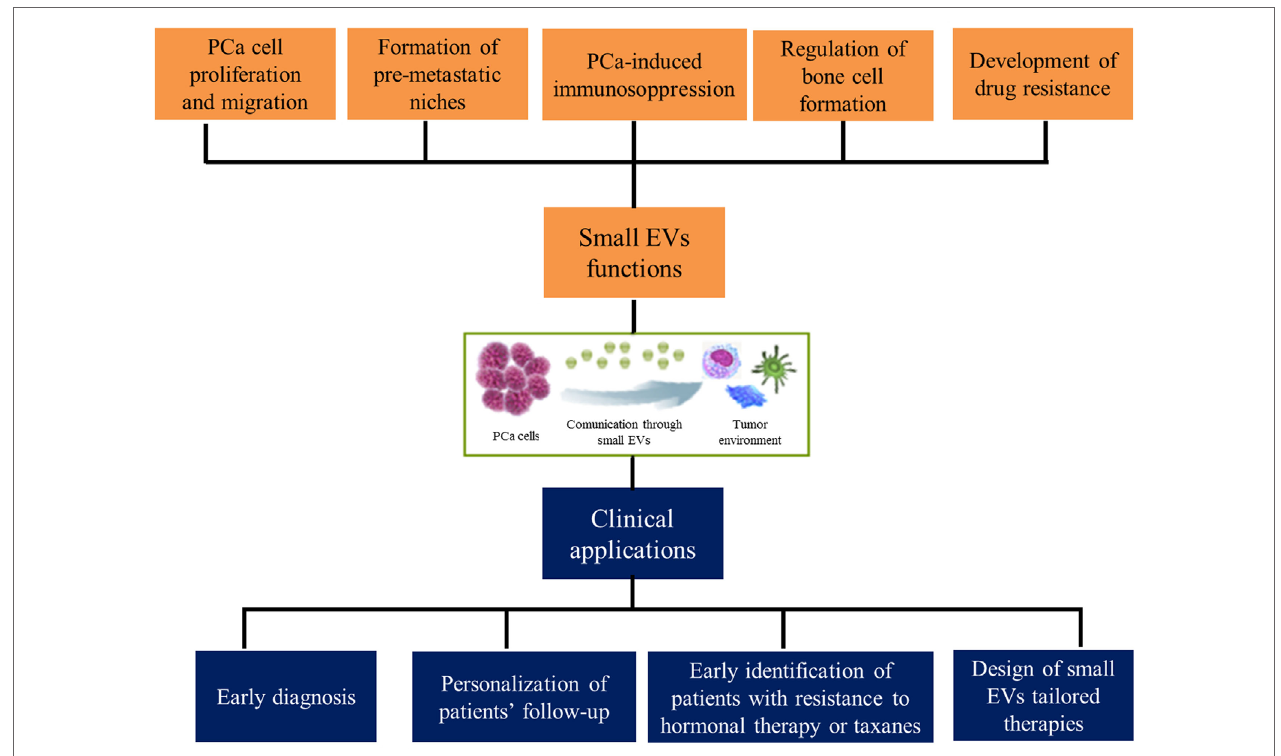
FiGURe 1 | Functions exerted by small extracellular vesicles (EVs) in prostate cancer (PCa) microenvironment and their clinical